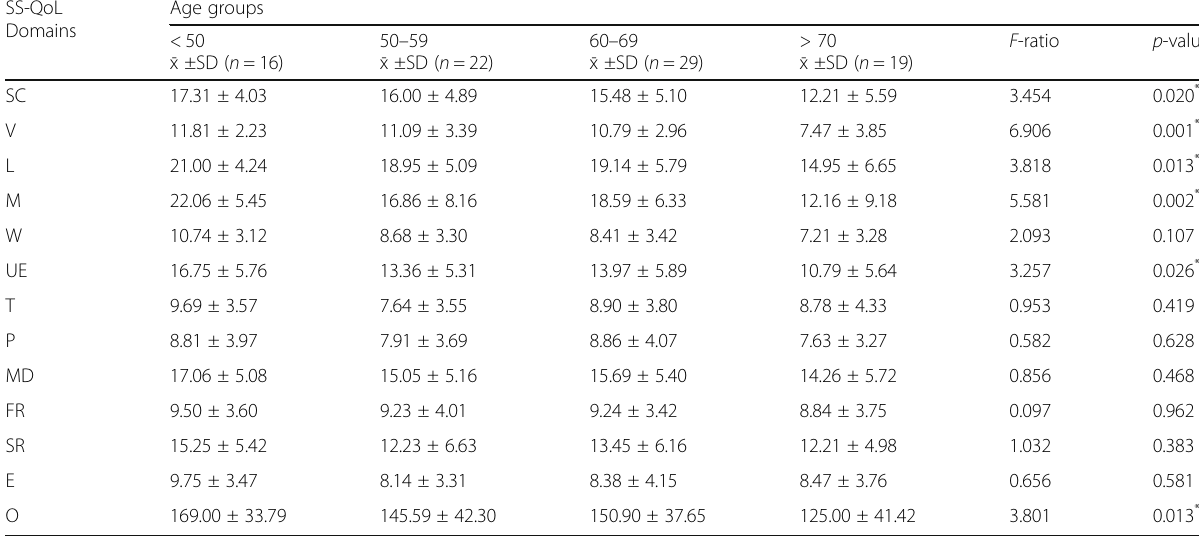
Table 6 One-way ANOVA comparison of the Hausa version of the Stroke-Specific Quality of Life 2.0 domains by age group SS-QoL